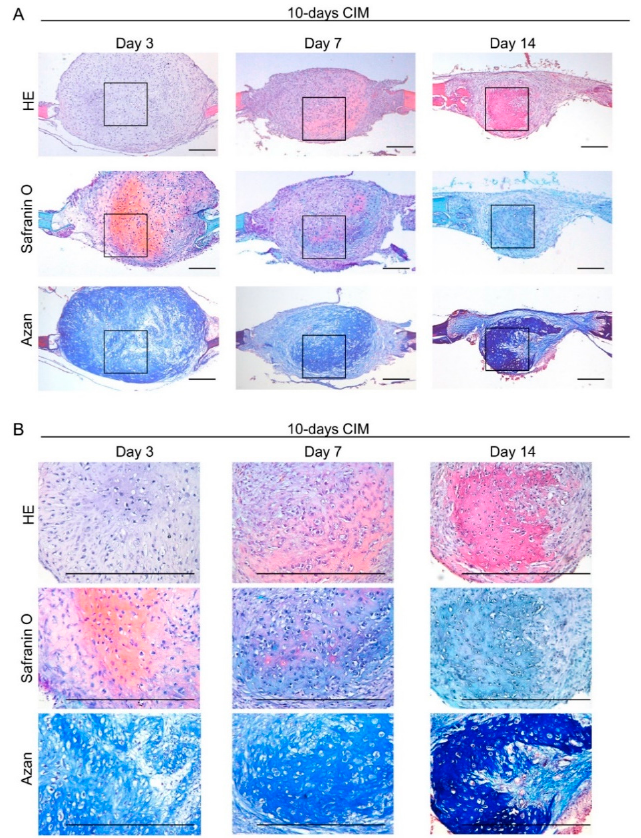
Figure 6. Transplantation of cartilage-like C-MSCs cultured with XF-CIM for 10 days causes endo- chondral ossification in the early period. ( A , B ) C-MSCs cultured with XF-CIM for 10 days were directly transplanted into a SCID mouse cranial defect of 1.6 mm in diameter. Eighteen defects were created in 9 animals. Animals were sacrificed at 3, 7, and 14 days after surgery and the cranial bones were fixed ( n = 6/each experimental periods). Semi-serial sections (8 μ m) were stained with HE, safranin O/fast green and azan, as indicated. ( A ) Lower magnification (Bar = 250 μ m). ( B ) Magnified images in the boxed regions (Bar = 50 μ m). 10-days CIM: transplantation of C-MSCs cultured in XF-CIM for 10 days. All images are representative of six samples.